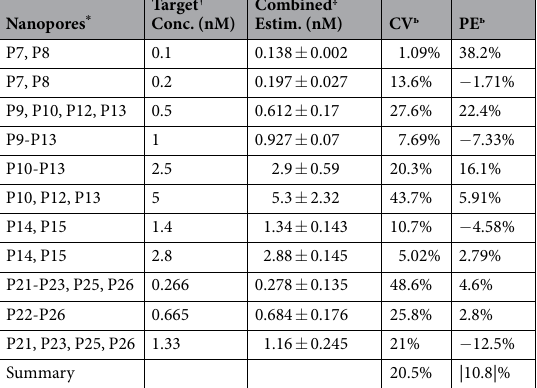
Table 1. Combining HGD65 concentration estimates from separate experiments. * Pores were grouped together by a common detection reagent (pores P7-P13 with 1074 bp, pores P14-P15 with 217 bp), or by the presence of saliva background (pores P21-P26, 10% saliva at incubation, 1% saliva above the pore after 10X dilution). † Target concentrations are above the nanopore after dilution. The pre-dilution incubation concentrations are reported in Table 2. ‡ Combined estimates are the mean and standard deviation of the single-pore estimates at each target concentration. The quantitative estimates for the individual pores listed are reported in the Supplementary Tables and plotted in Supplementary Fig. S22. ь Coefficient of variation (CV) is the standard deviation divided by the mean. Percent error (PE) is the ratio of the error (estimate minus known value) to the known value, converted to a percentage. Summary reports the mean CV and the mean of the absolute PE values across all